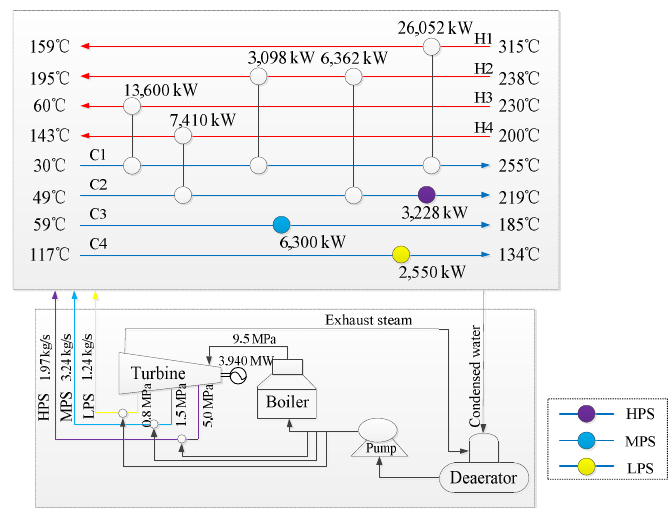
Figure 2. Structure with minimum TAC of Scenario 1.